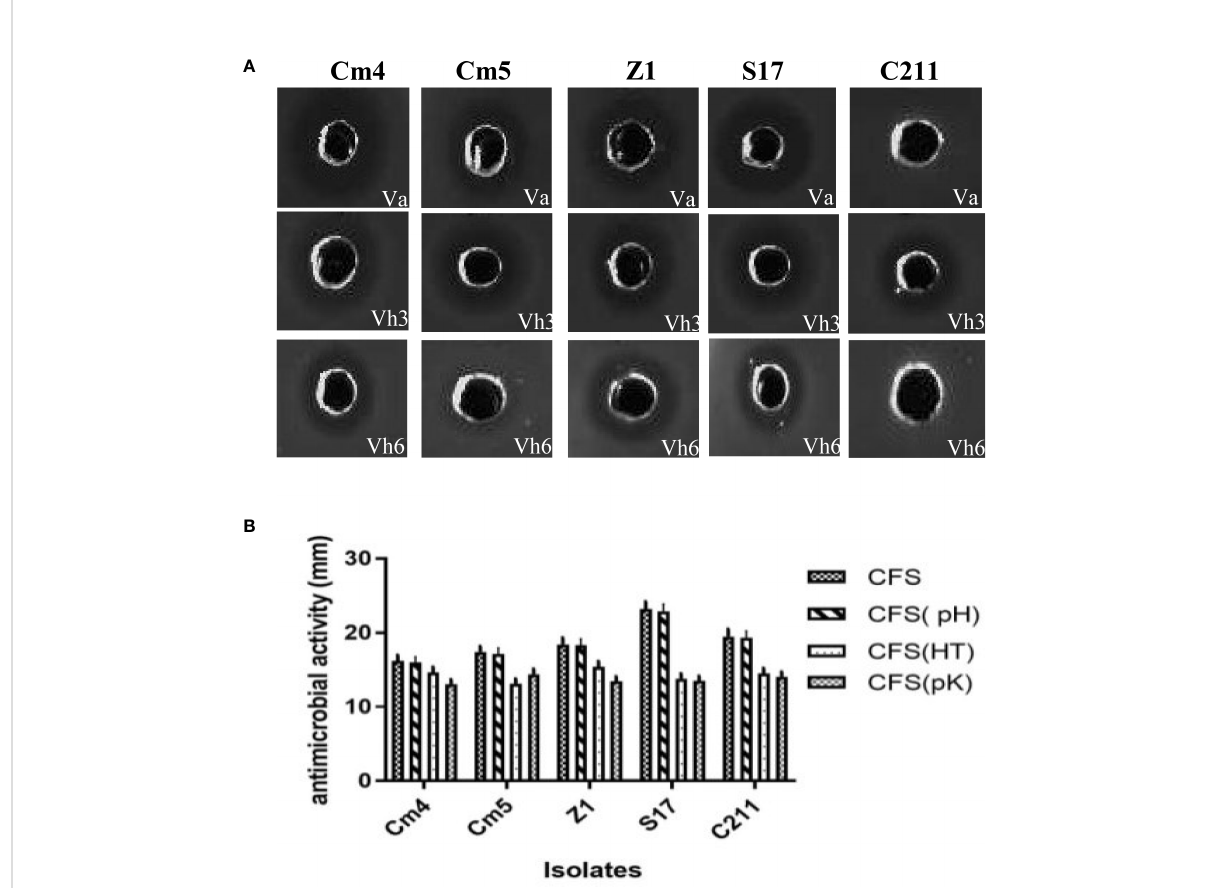
FIGURE 3 (A) Pictorial overview of antibacterial activity of selected strains against indicators (VA, Vibrio anguillarum CECT4344; Vh3, Vibrio harveyi Lg 26/ 01and Vh4, V. harveyi Lg 34/04) and (B) nature of their antagonistic activity against Vibrio anguillarum CECT4344 using agar